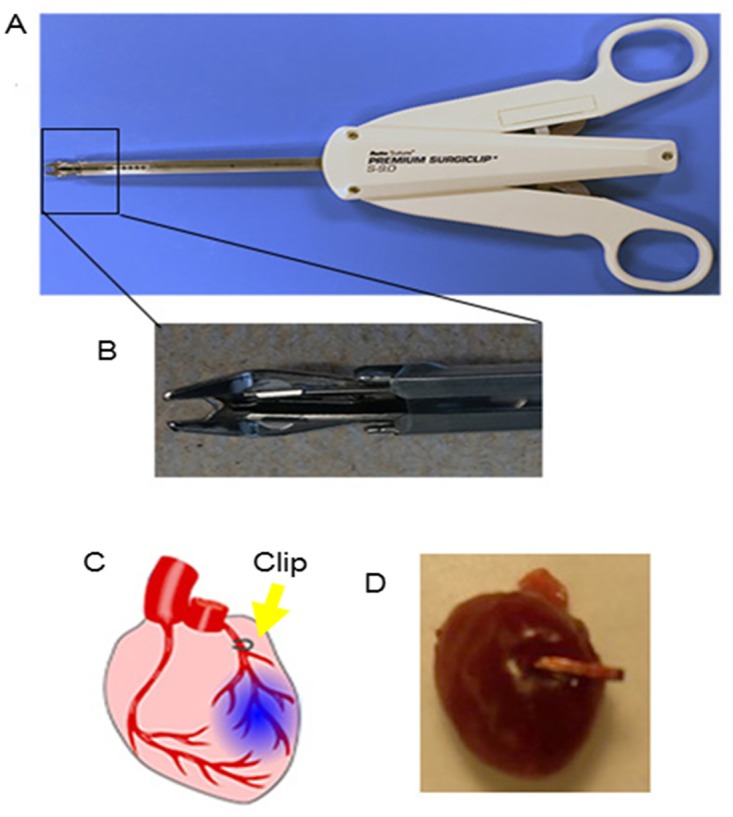
Surgical clip for LAD ligation.(A) & (B): Pictures showing the surgical clip dispenser and its tip containing the metal clip; (C) & (D): Schematic and gross heart picture showing left anterior descending artery (LAD) ligation by a surgical clip.